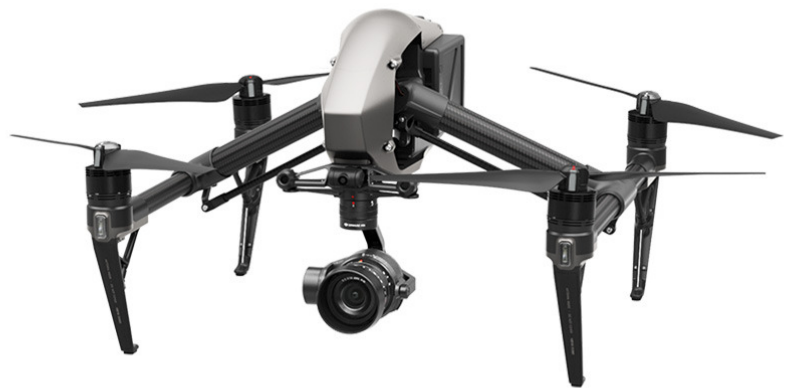
Figure 3. Inspire 2 with Zenmuse X5S for crack